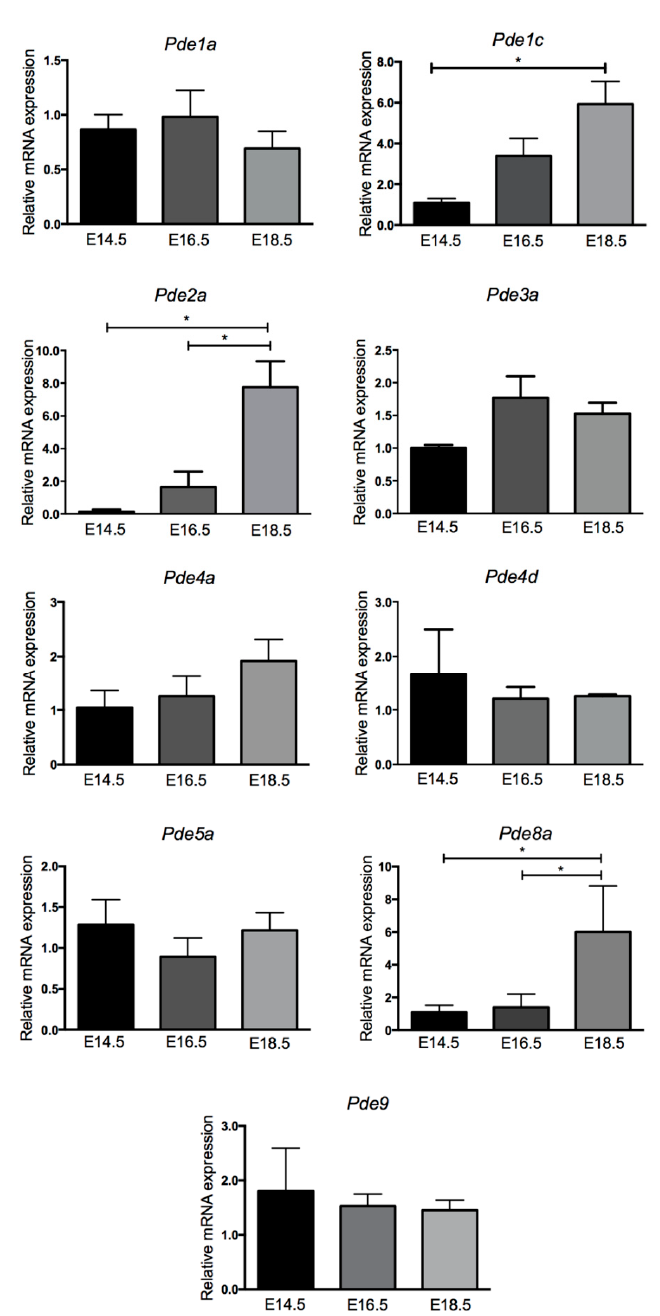
Figure 1. PDE gene expression during heart formation. qRT-PCR analysis of Pde1a , Pde1c , Pde2a , Pde3a , Pde4a , Pde4d , Pde5a , Pde8a and Pde9 mRNA expression in E14.5, E16.5 and E18.5 mouse hearts. The relative expression was normalized versus Gapdh gene. Data represent the mean ± SD of five hearts for each stage. One-way ANOVA was used for statistical analysis. * p < 0.05.